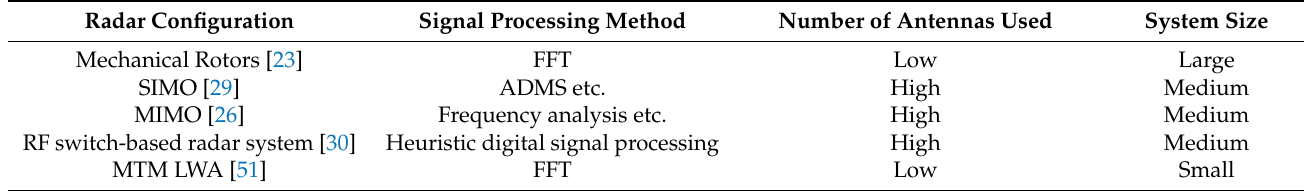
Table 3. Main properties of methods for multi-target detection using radar